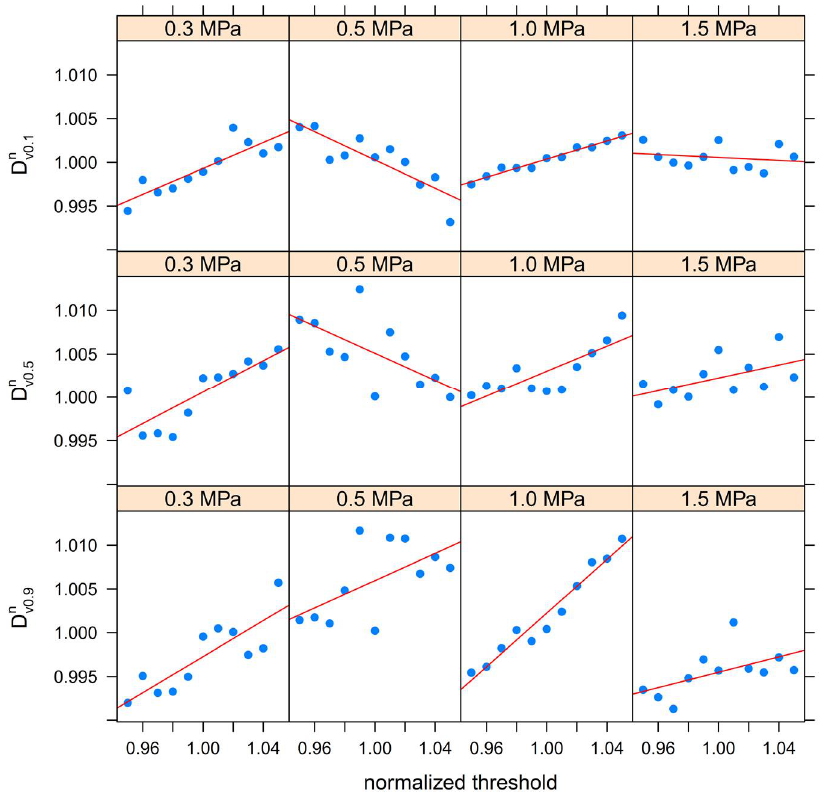
Figure 6. Variations in normalized volumetric diameters (cid:1830) (cid:3049)(cid:2868).(cid:2869)(cid:3041) , (cid:1830) (cid:3049)(cid:2868).(cid:2873)(cid:3041) , and (cid:1830) (cid:3049)(cid:2868).(cid:2877)(cid:3041) .with respect to the normalized threshold.